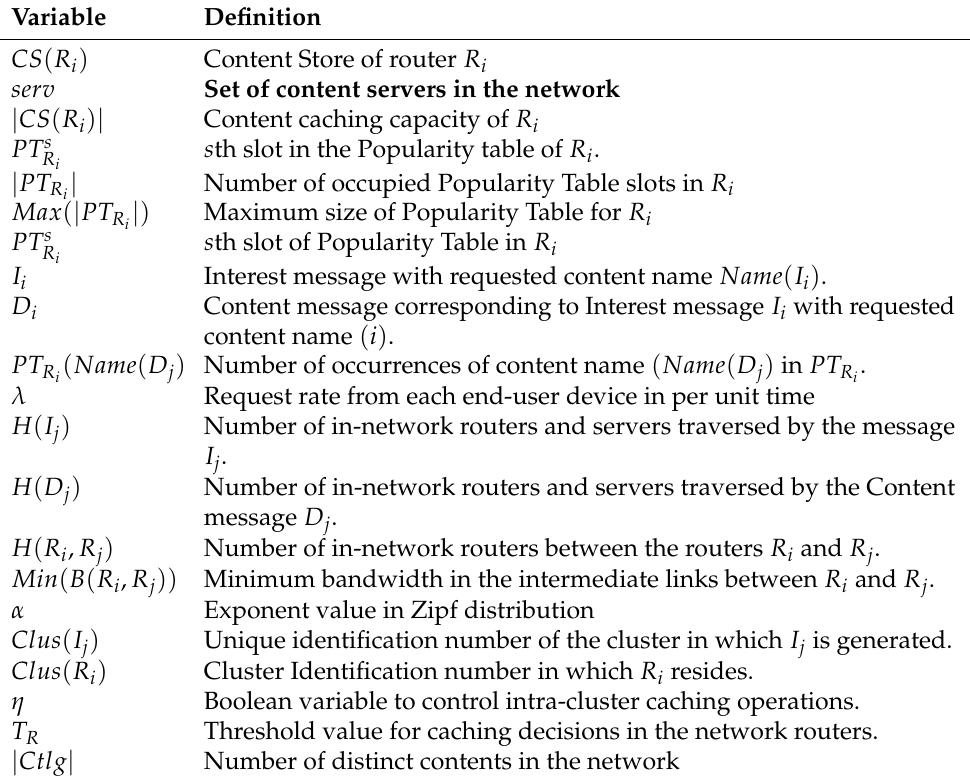
Table 2. Variables